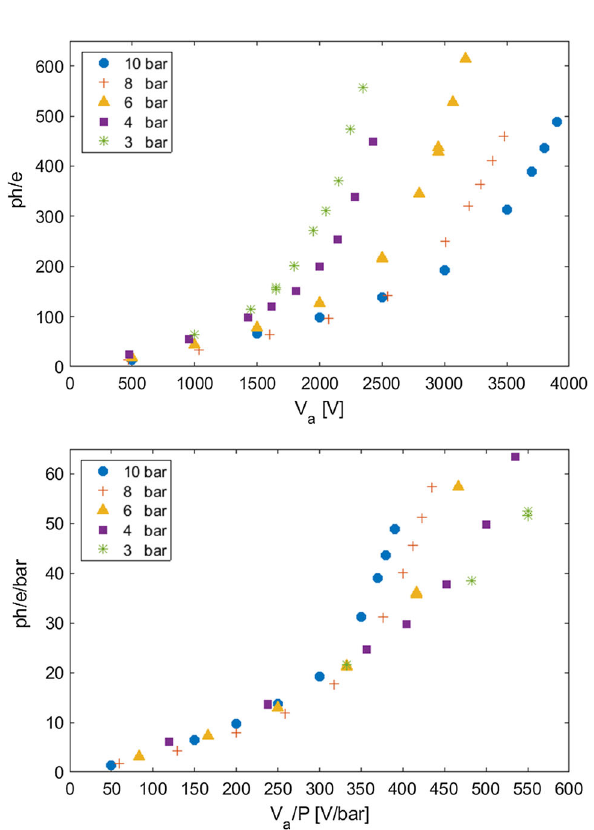
Fig. 18 Top: absolutely normalized secondary scintillation yields as a function of pressure, measured by the unfiltered PM (145–600 nm). Bottom: scintillation yields in a pressure-reduced representation. The drift field is 50 V/cm/bar in all cases and the overall systematic error is estimated to be less than 25%